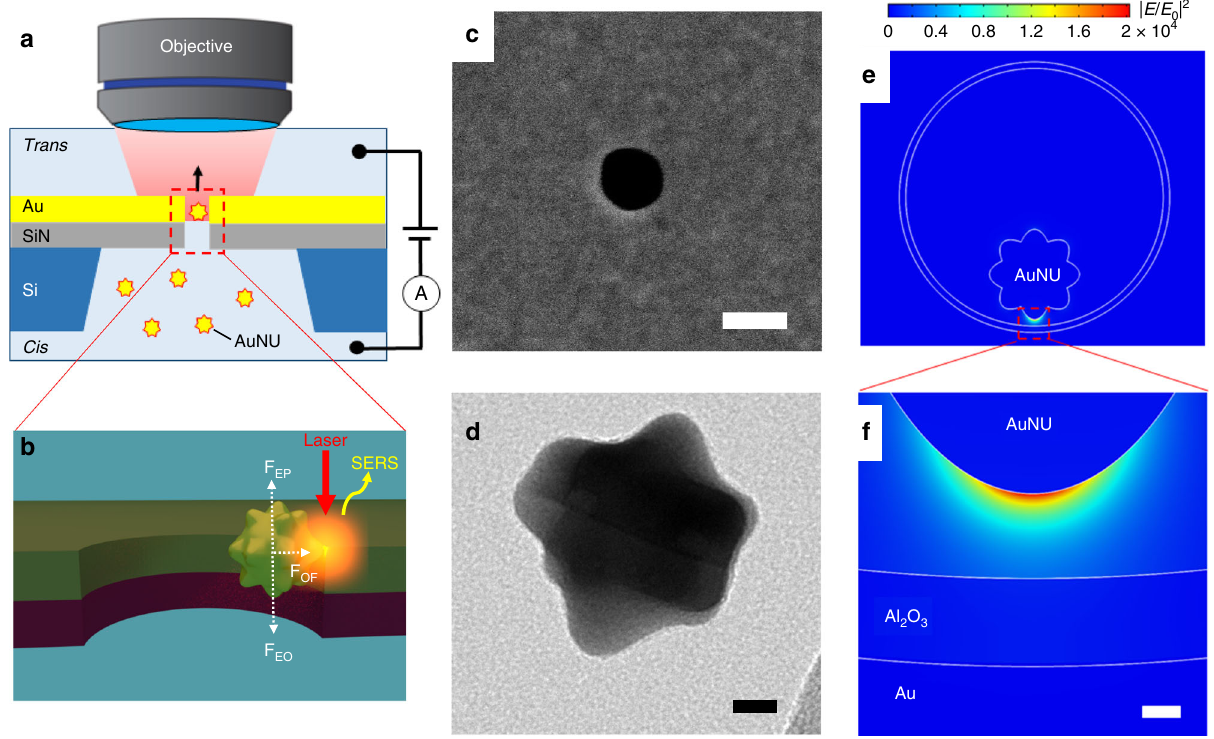
Fig. 1 Electro-plasmonic trapping for single-molecule SERS. a Schematic of the fl ow-through setup that allows single gold nanourchin (AuNU) to fl ow through and be trapped under applied bias in a gold nanohole at plasmonic resonance upon the laser excitation at 785 nm. b The trapping due to a balance between the electrophoretic ( F EP ), electroosmotic ( F EO ), and optical ( F OF ) forces leads to a plasmonic hot spot between the AuNU tip and the nanohole sidewall that allows single-molecule SERS. c SEM image of the gold nanohole. The scale bar is 200 nm. d TEM image of the AuNU. The scale bar is 10 nm. e Simulated electromagnetic fi eld intensity distributions of the AuNU coupled with the nanohole. The color bar represents the enhancement of the electromagnetic fi eld intensity. f Magni fi ed view of the intensity distribution of the electromagnetic fi eld at one tip of the AuNU. The scale bar is 2